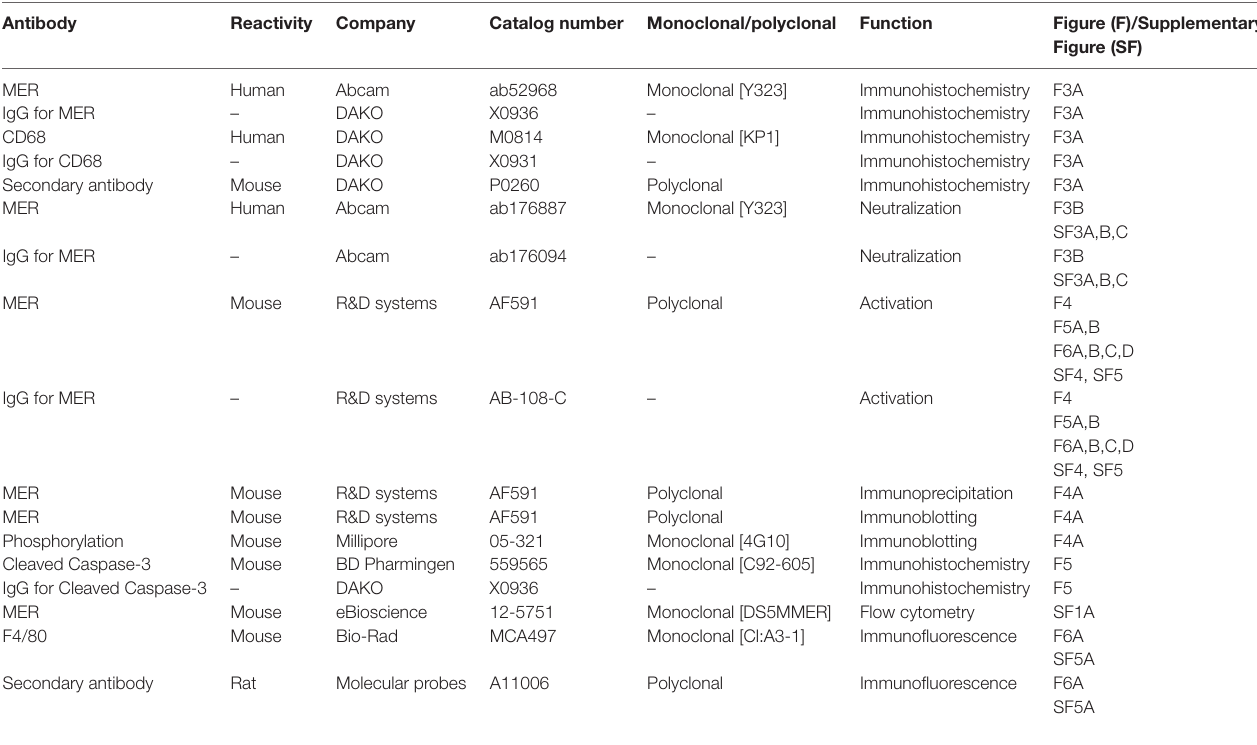
Table 1 | List of antibodies, origin, and function.